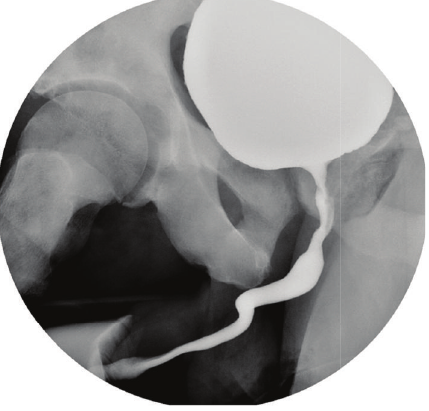
Figure 4: Voiding